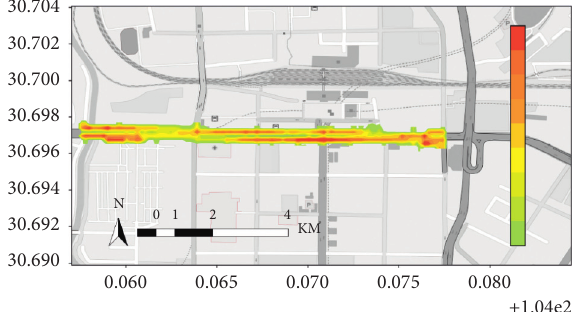
Figure 19: Safety assessment of closed straight section.